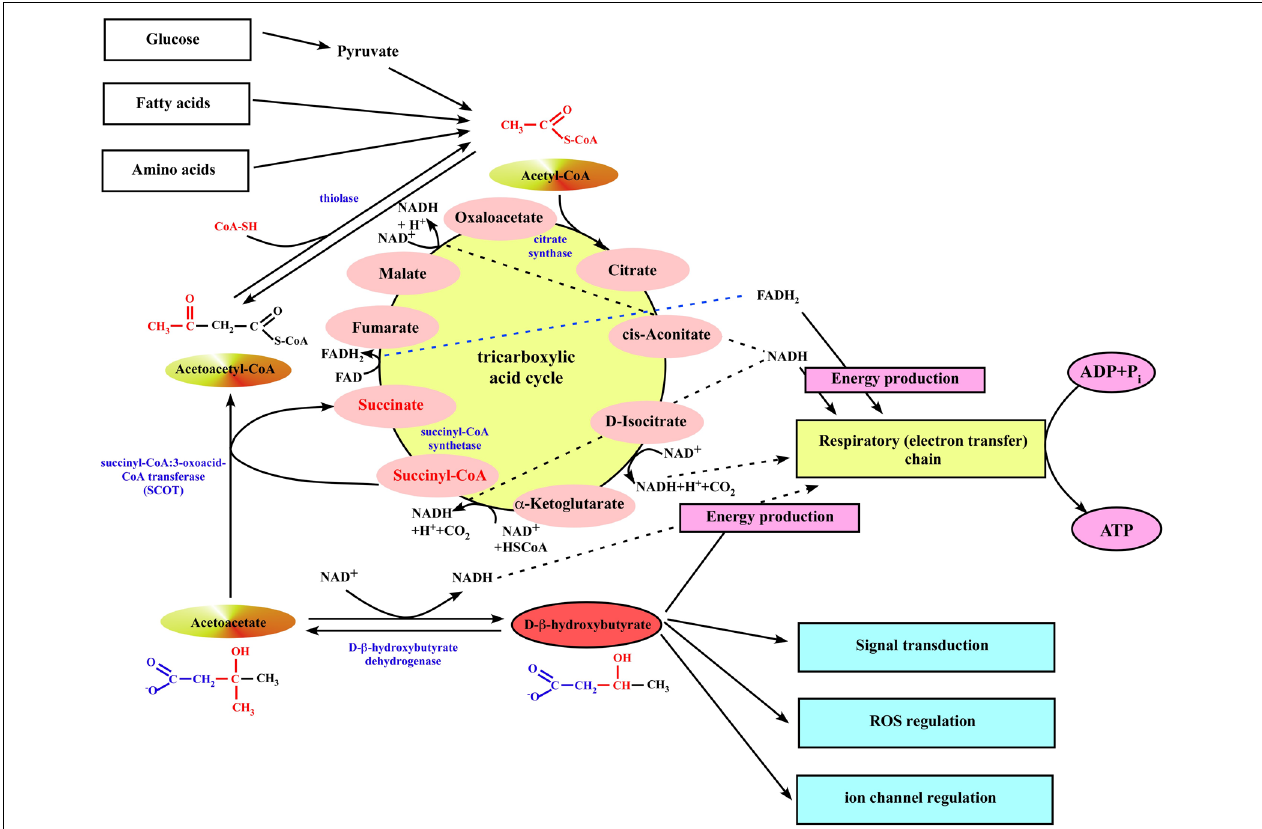
FIGURE 2 | Ketone body utilization in mitochondria of extrahepatic organs. When ketone bodies are delivered to the peripheral organs, β -OHB is oxidized back to acetoacetate by the mitochondrial BDH1. Then, acetoacetate gets converted to acetoacetyl-CoA by the mitochondrial enzyme succinyl-CoA: 3-oxoacid-CoA transferase (SCOT). The succinyl-CoA:3-oxoacid-CoA